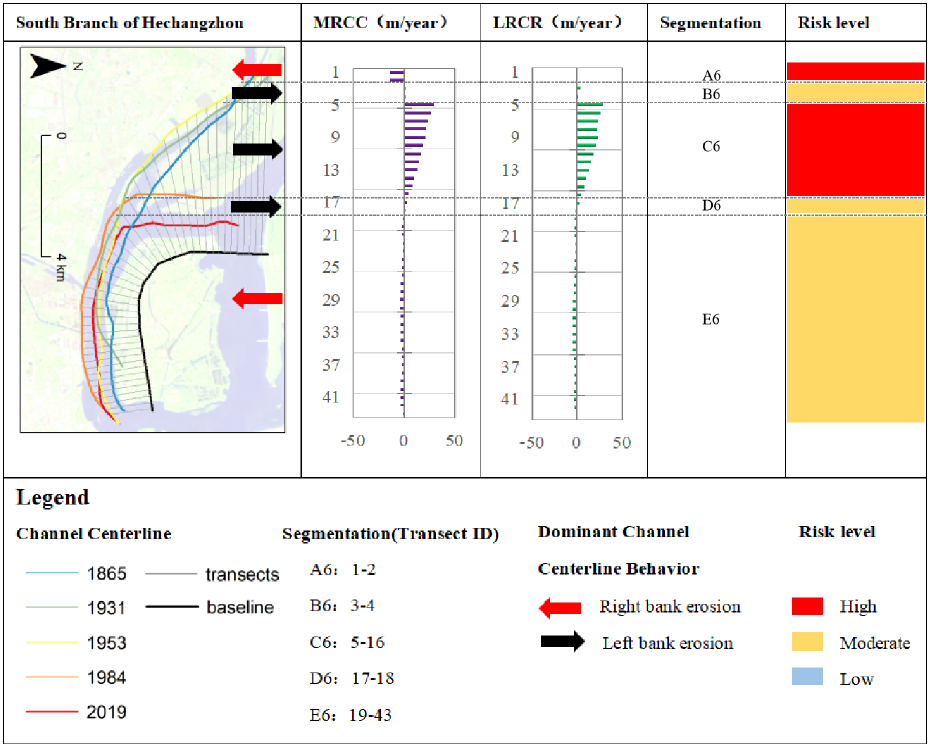
Figure 9. The Migration Rate of Channel Centerline, Linear Regression Change Rate, and erosion risk identification on North Branch of Hechangzhou.